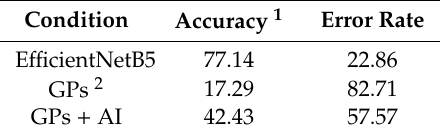
Table 4. Classification metrics of non-dermatologists, general practitioners with or without use of the algorithmic platform and with time constraints.